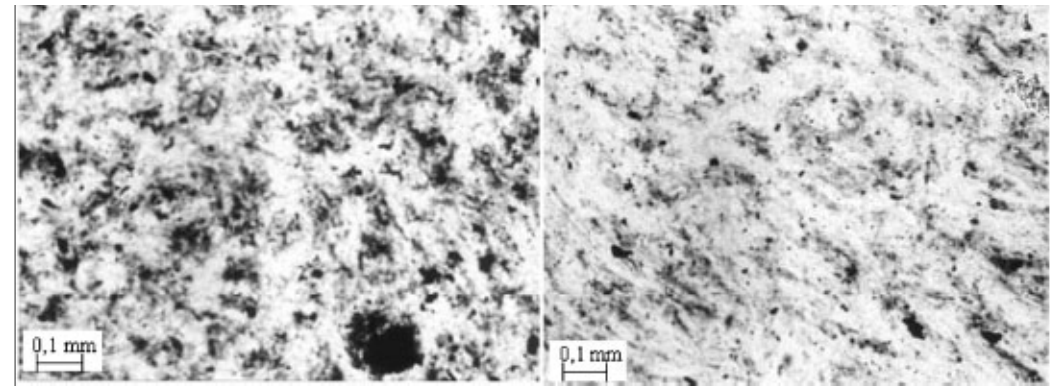
Figure 53. Micrographs of sPP/MWCNTs nanocomposites prepared with prereaction after sonication of the nanotubes with different amplitudes (left: 10%, right: 30%). Reproduced with permission from ref.